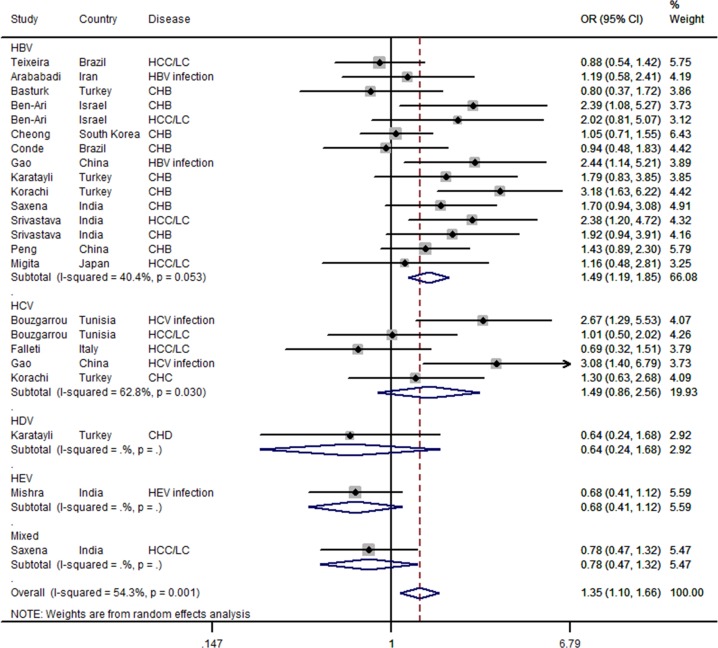
Forest plot for the association between IFN-γ +874T/A polymorphism and hepatitis virus-related diseases risk stratified by hepatitis virus type in a recessive model (AA vs. TT+TA) using a random-effects mode.The squares and horizontal lines correspond to the study-specific OR and 95%CI. The diamond represents the summary OR and 95%CI.